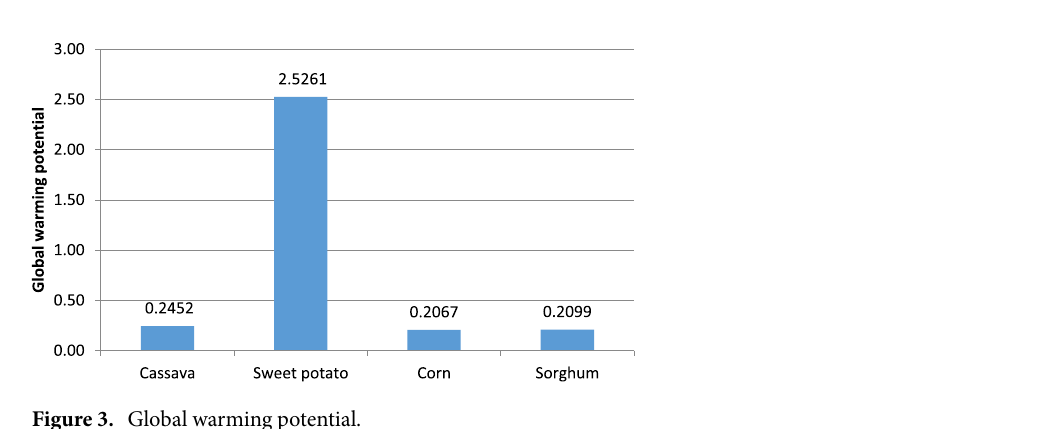
Figure 3. Global warming